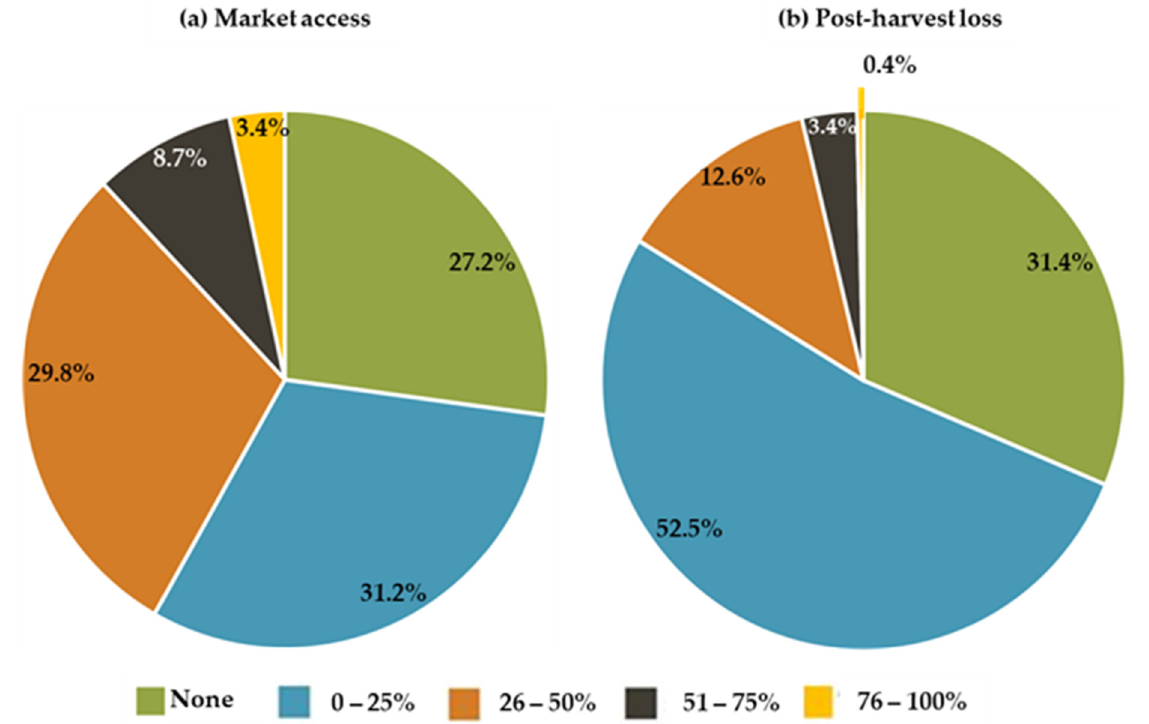
Figure 6. Share of crop production sold at market ( a ), and post-harvest loss ( b ), due to COVID-19 among respondents ( n = 802).